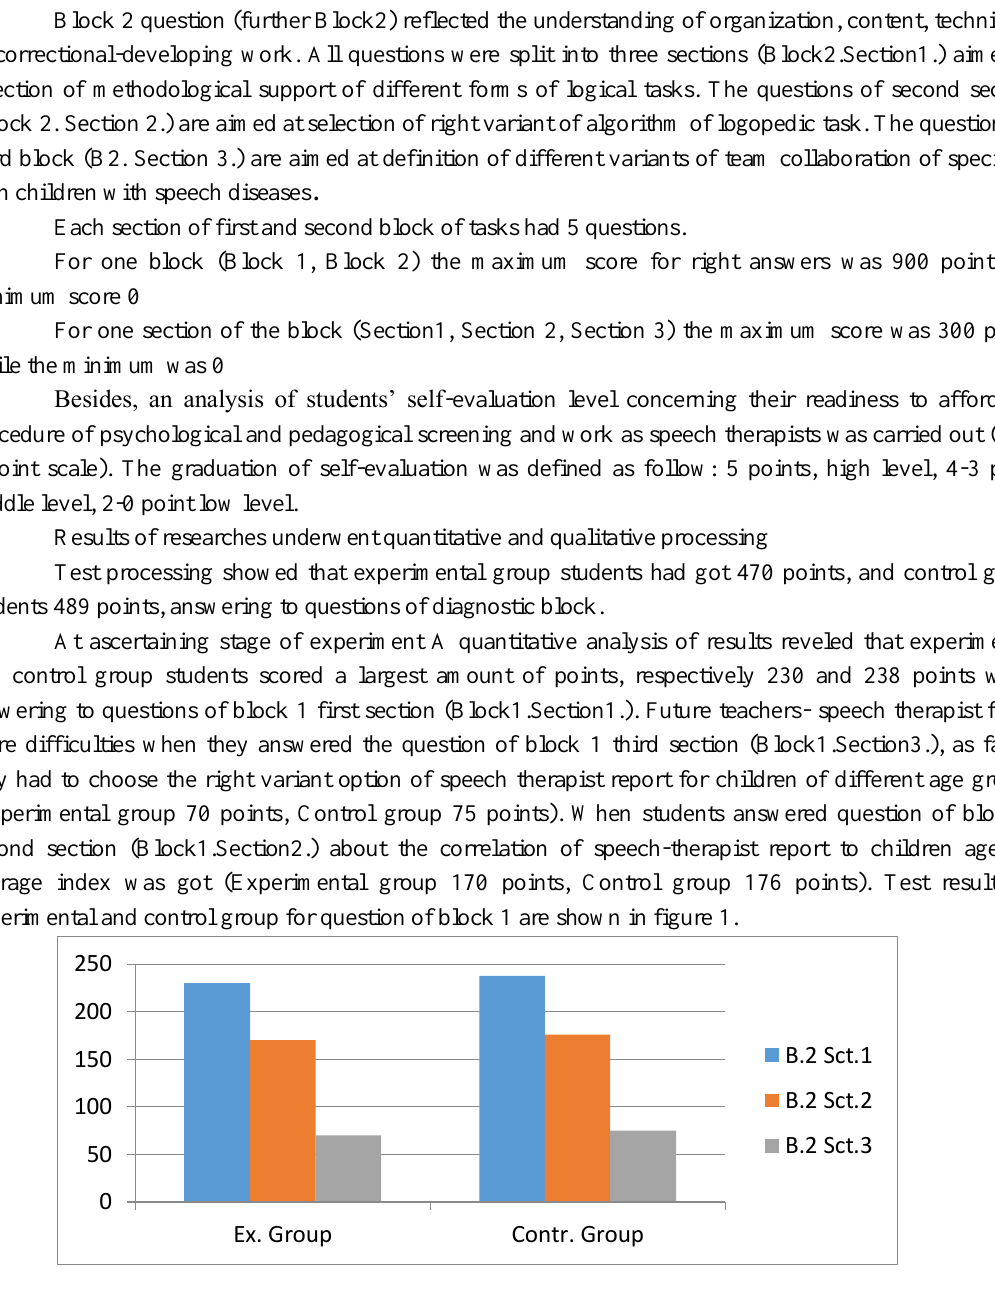
Figure 1. Test results for questions of block 1 at ascertaining stage of experiment While answering questions of Block 2 (organization and content of correctional-developing